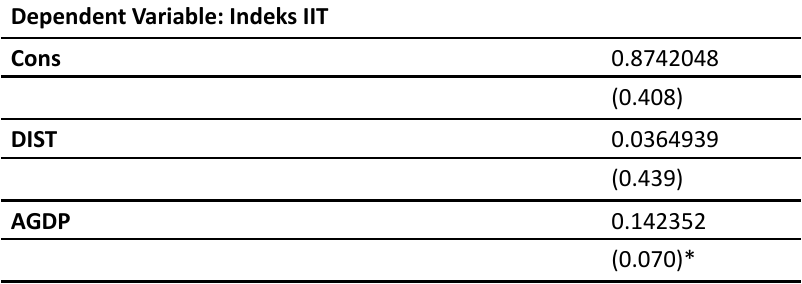
Table 2: Test Results of Classical Cure